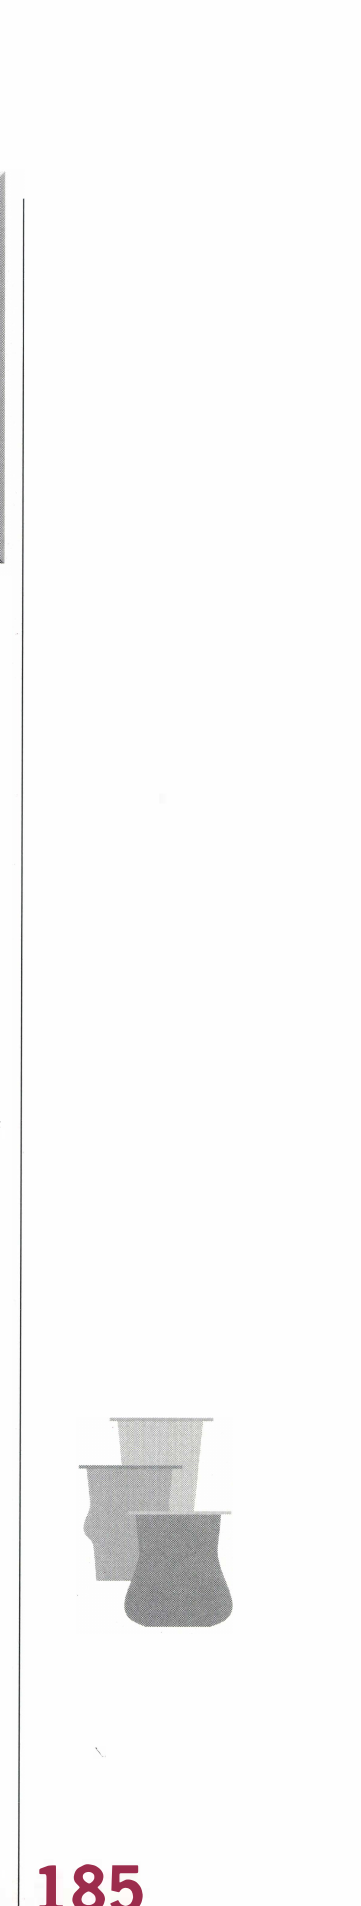
Fig. 3: Different regeneration behaviour after preceding shear